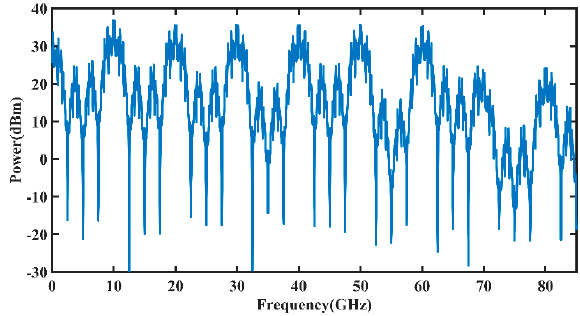
Figure 4. The spectrum of PSK signal at eight wavebands.